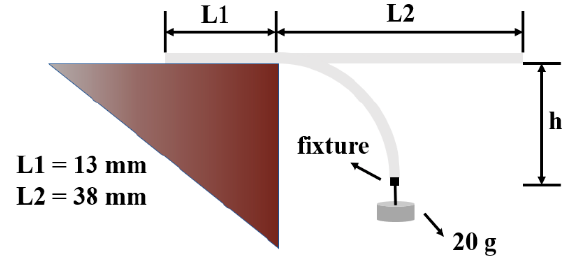
Figure 2. Flexibility test